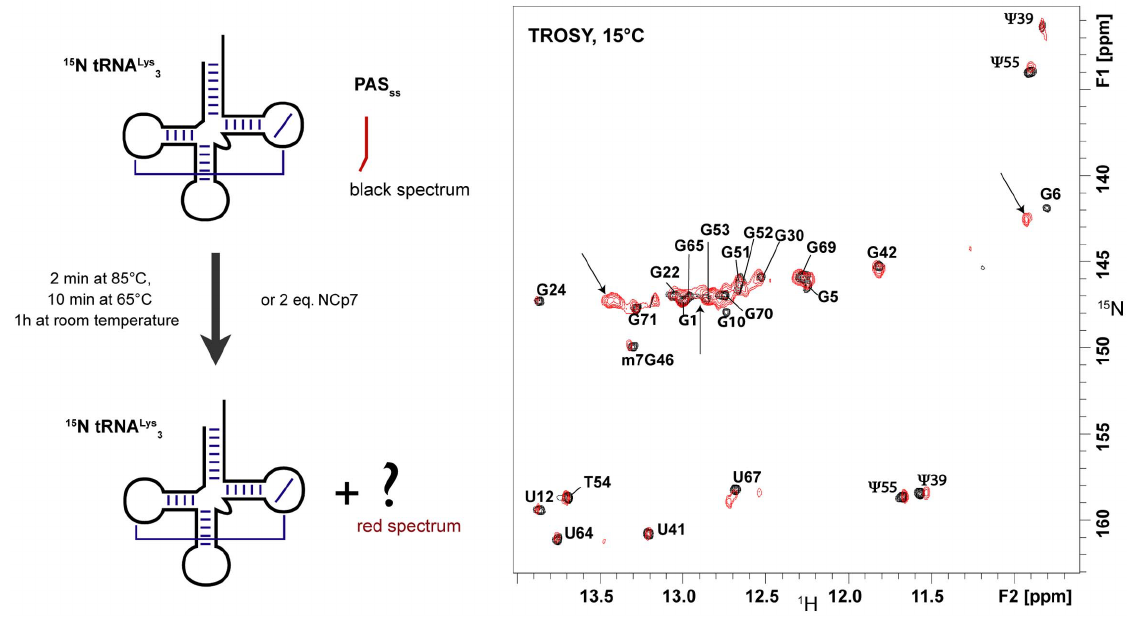
Figure 3. Tests of annealing of PAS ss to tRNA Lys 3 . A) Schematic drawing of the experimental procedure, B) Superimposition of two TROSY experiments recorded at 15 u C showing the imino groups of tRNA Lys 3 (0.1 mM) alone (in black, reference spectrum) and after the heat-annealed procedure with 1 equivalent of PAS ss (red spectrum). The arrows indicate peaks corresponding to the PAS/anti-PAS complex described in Figure 7.